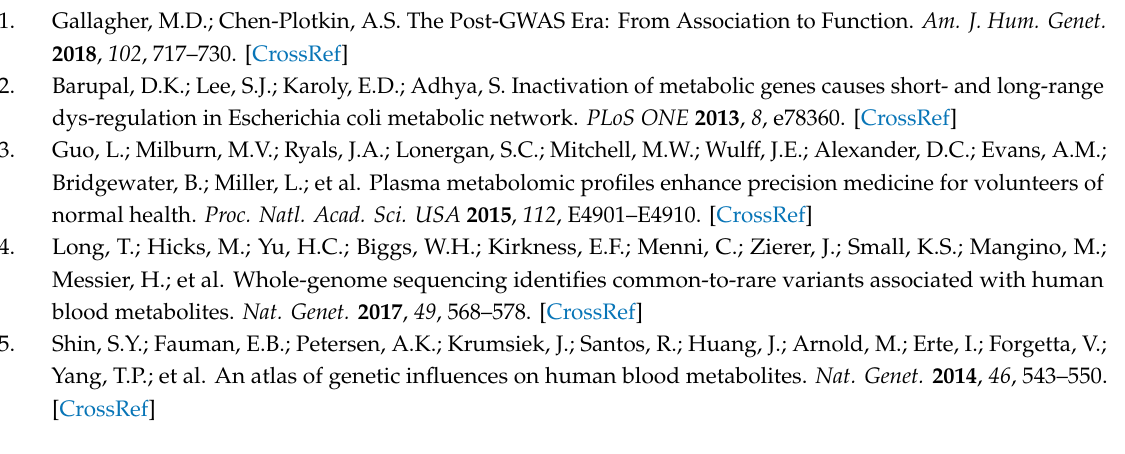
Table S14: Data Matrix; Table S15: Sample metadata; Table S16: Reagents and material used; Table S17: Analysis sequences for all assays; Table S18: Internal standards for LCMS assays; Figure S1: Total ion chromatogram plots for LC-MS data of quality control